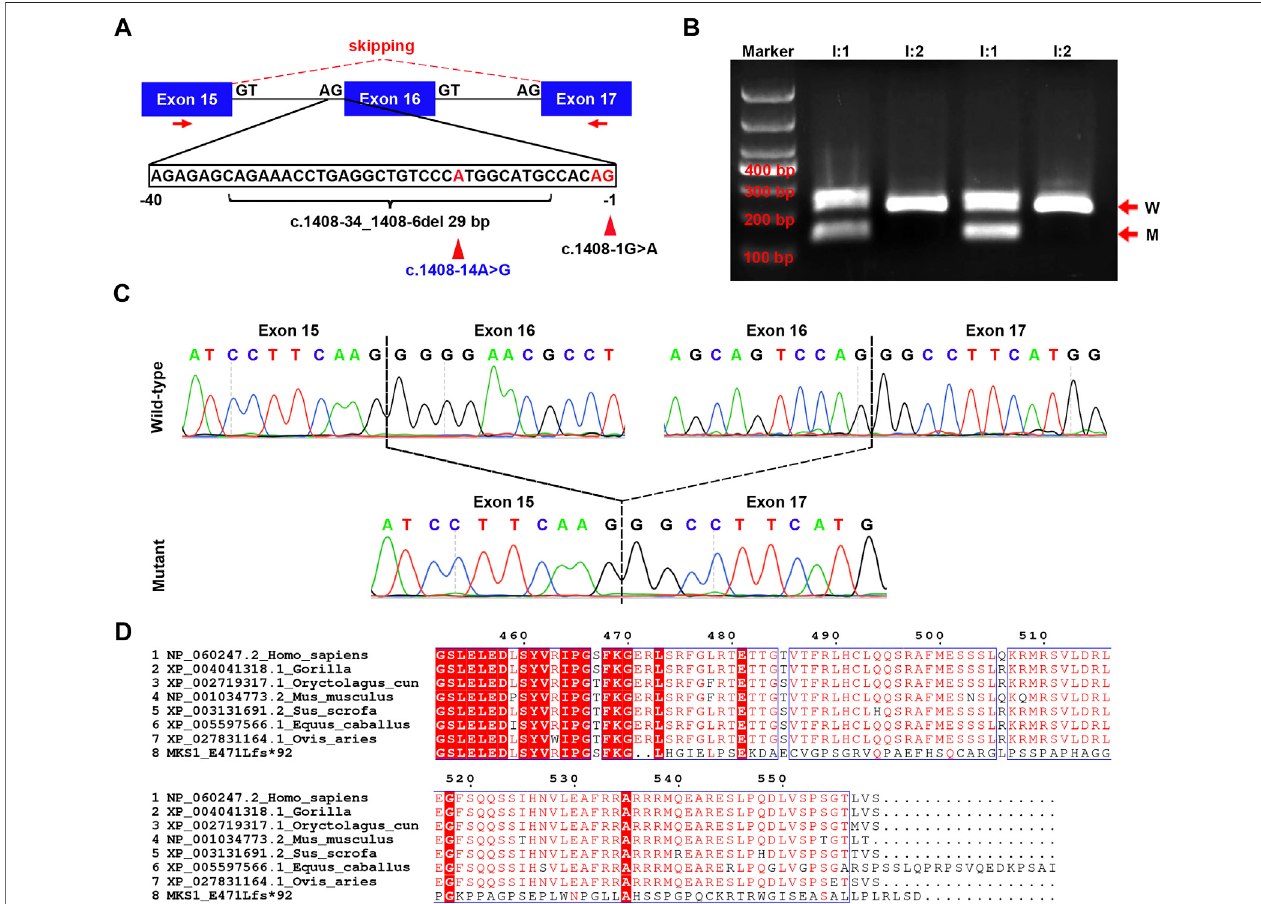
FIGURE2| Con fi rmationfortheeffectofc.1408-14A > Gon MKS1 mRNAsplicing. (A) Schematicofthethreeexons(exons15,16,and17),thepartialsequenceof intron 15, and the location of three variants (c.1408-1G > A, c.1408-14A > G, and c.1408-34_1408-6del29bp). The red arrows indicate the localization of primers used in RT-PCR. (B) Imageofagarose gelelectrophoresis oftheRT-PCRproducts fromthecouple(I:1and I:2).Thered arrowsshowthewild-type (W)andmutant (M)product. (C) SangersequenceoftheRT-PCRproducts.Theupperpanelshowsthewild-type MKS1 sequencewithtwodashedlineslabelingtheboundaryofexon15/exon 16andexon16/exon17.Inthemutantsequence,exon15wasligateddirectlywithexon17,manifestingtheshipofexon16duringmRNAsplicing. (D) Alignmentresults of human wild-type and mutant MKS1 proteins with other species (gorilla, pig, horse, sheep, rabbit, and mouse). Only the C-terminal sequence is